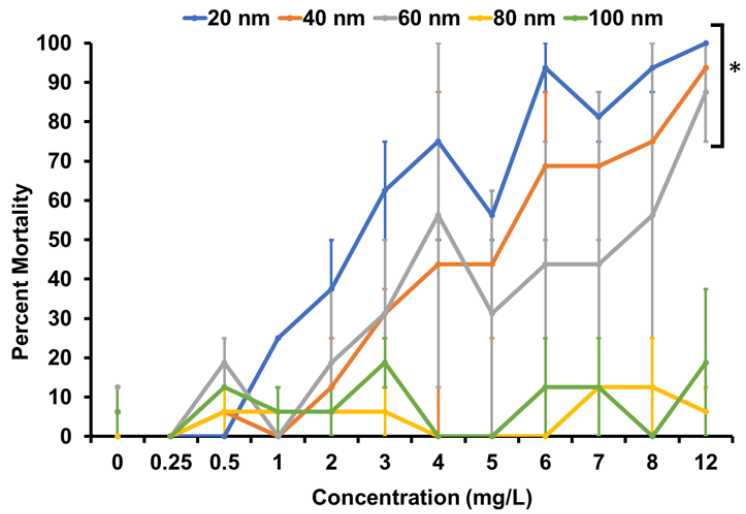
Figure 3. Concentration-response of zebrafish exposed to varying concentrations of hybrid lipid- coated AgNPs for total mortality at 120 hpf. Data represent two experimental replicates ( n = 8 for each) for a total of n = 16 for each exposure condition. Bars show standard error. * indicates significant difference from the control ( p -value ≤ 0.05).